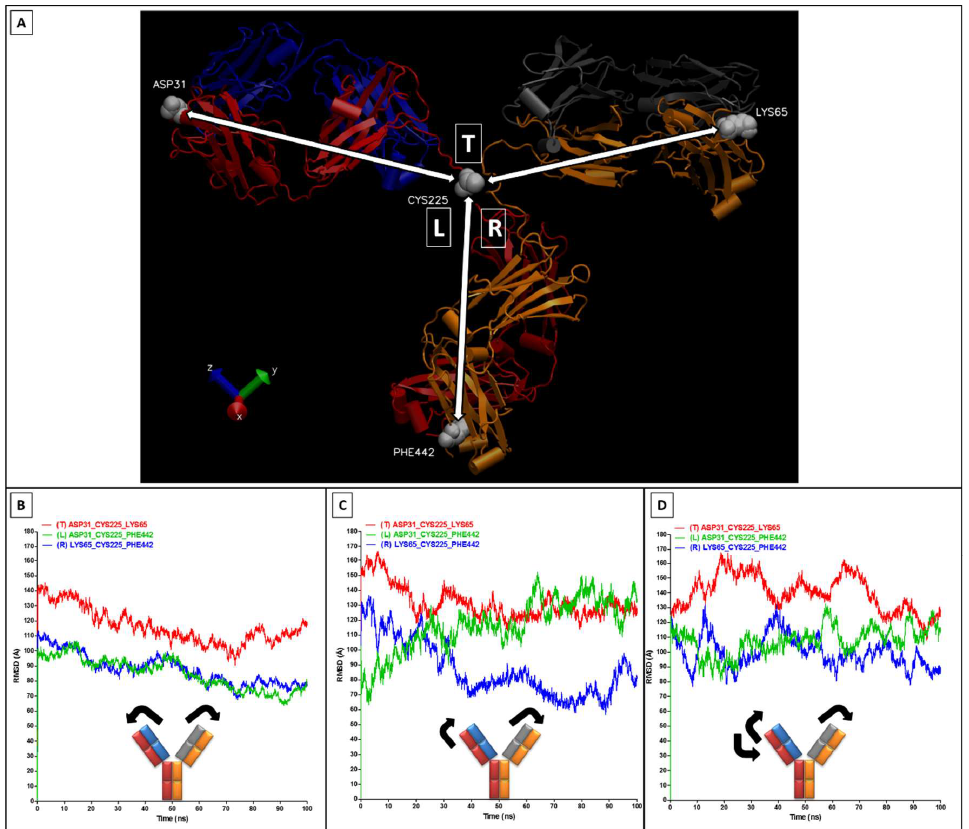
Figure 6. Movement analysis of the antibody Fabs and Fc fragments. Movements of the angles shown in ( A ); These angle changes were measured through each of the three simulations as illustrated in ( B ) explicit; ( C ) implicit; and ( D ) explicit_ions.